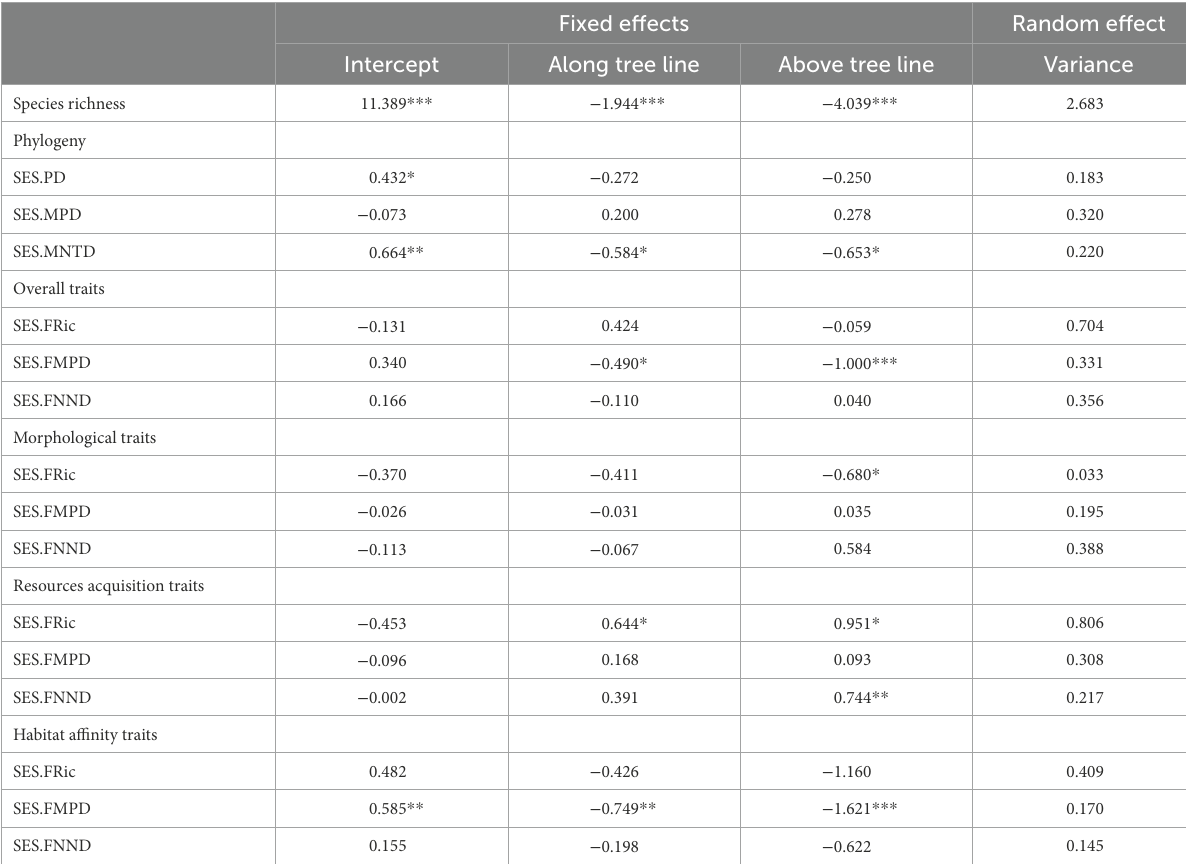
TABLE 1 Results of linear mixed-effect